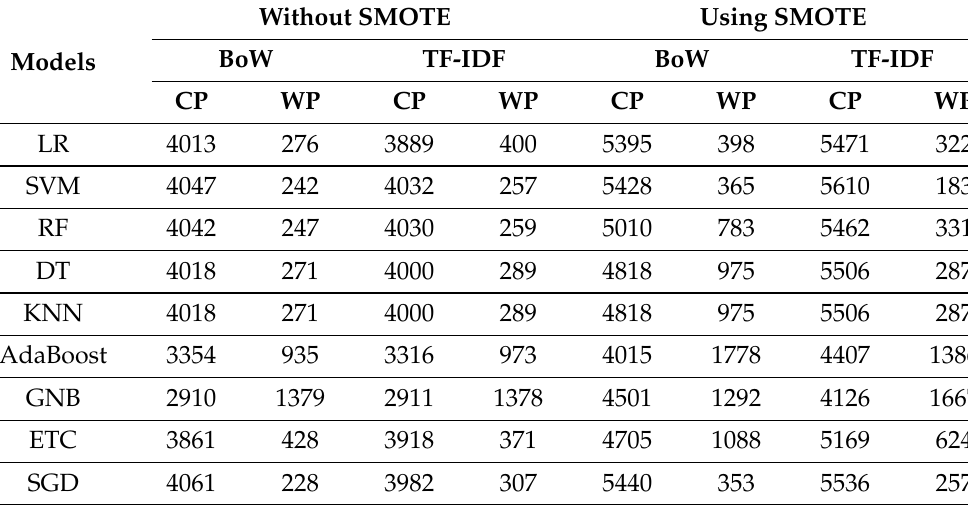
Table 15. Confusion Matrix of a model using TF-IDF and BoW without SMOTE and using SMOTE.